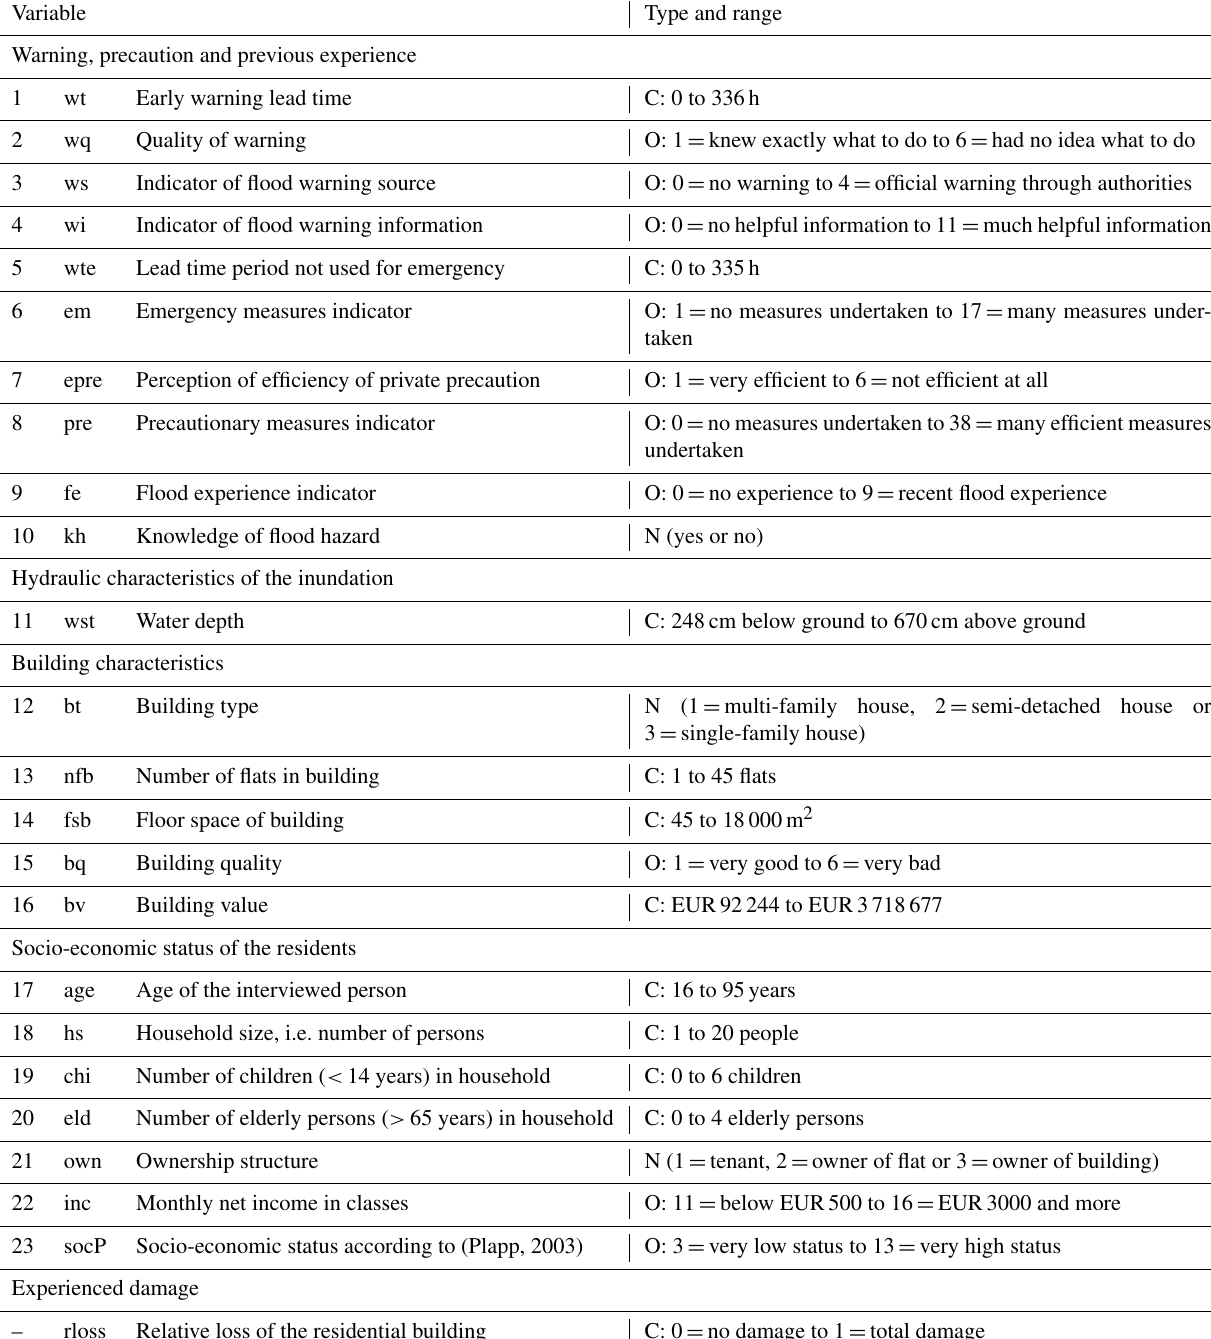
Table 1. Preselected variables from CATI surveys; C: continuous, O: ordinal, N: nominal-scaled variables. Variable Type and